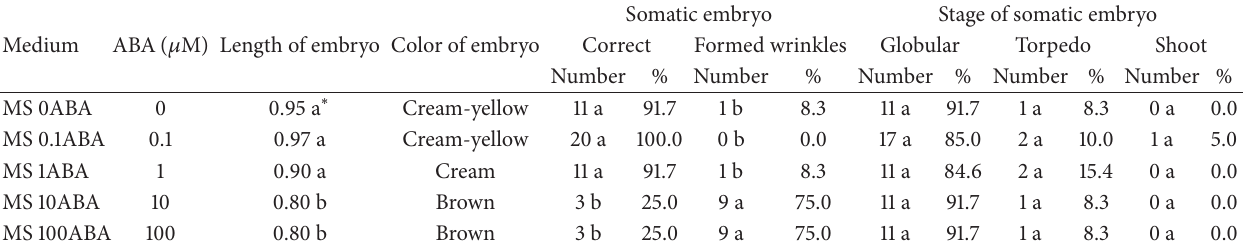
Table 1: The influence of ABA on direct somatic embryogenesis in cactus C. tenuissima Ritt. forma monstruosa . Somatic embryo Stage of somatic embryo